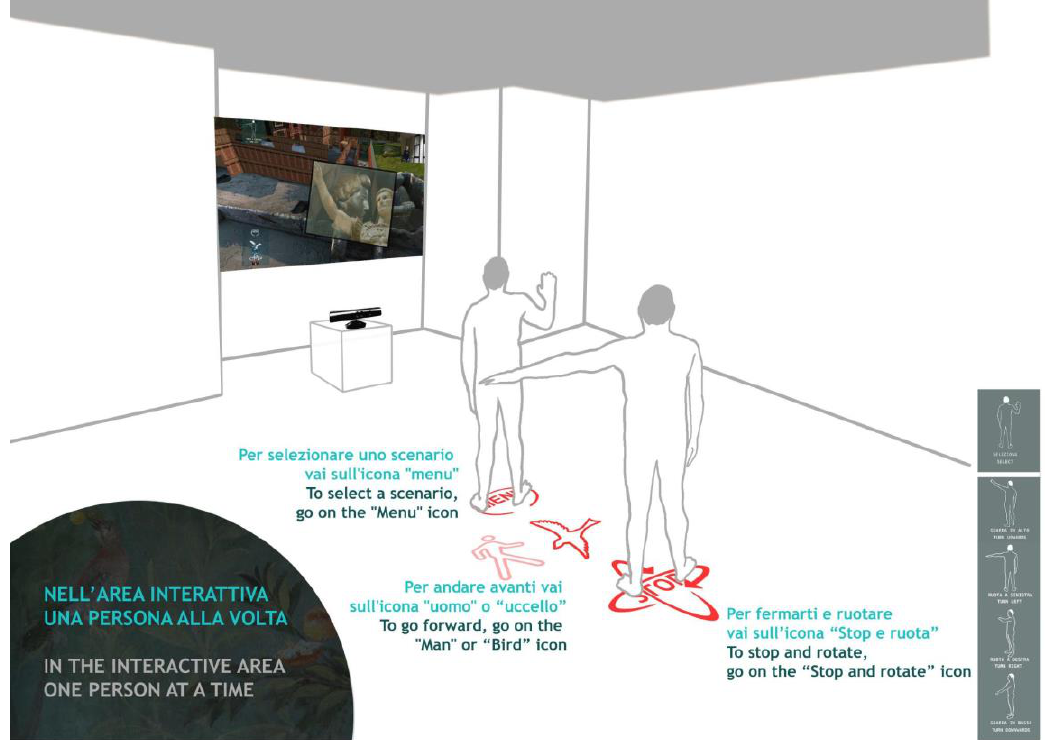
Figure 10. Gestures grammar lets the user interact with Livia’s Villa Reloaded VR installation: flight over the archaeological site, walk through the reconstructed villa. Realized by CNR ITABC in collaboration with E.V.O.CA. in 2014, for the National Roman Museum, Diocletian’s